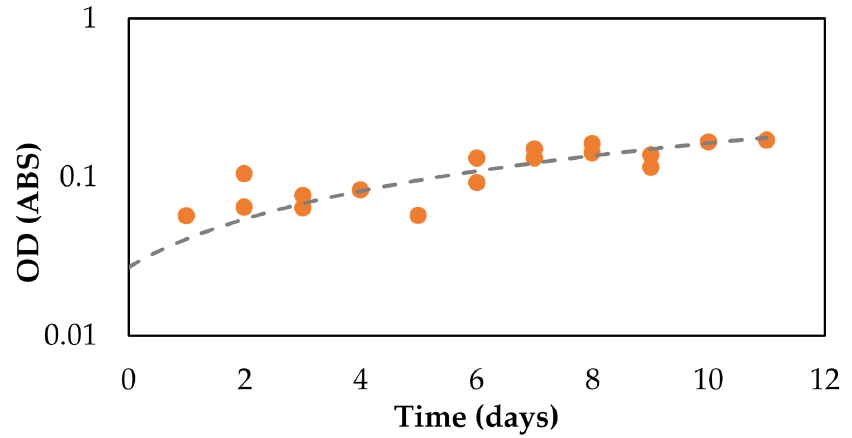
Figure 1. Growth curve of Alcanivorax borkumensis SK2 in ONR7a with HOF-2 and N and P nutrients. Optical Density (OD) vs. Time.